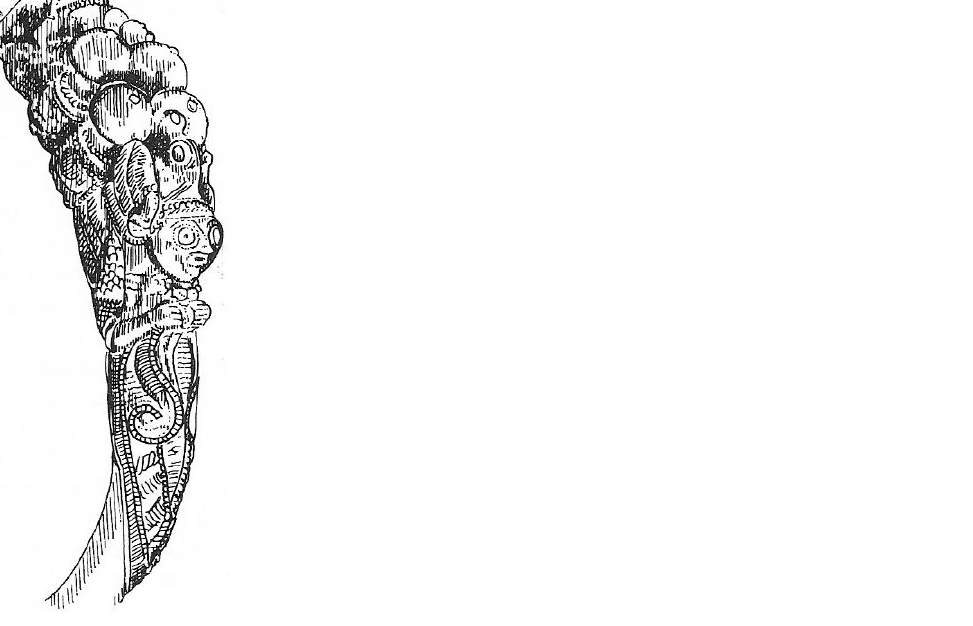
Figure 3. Detail of gold ring jewellery from a woman’s grave at Reinheim, Germany; fourth century BC. © Paul Jenkins.